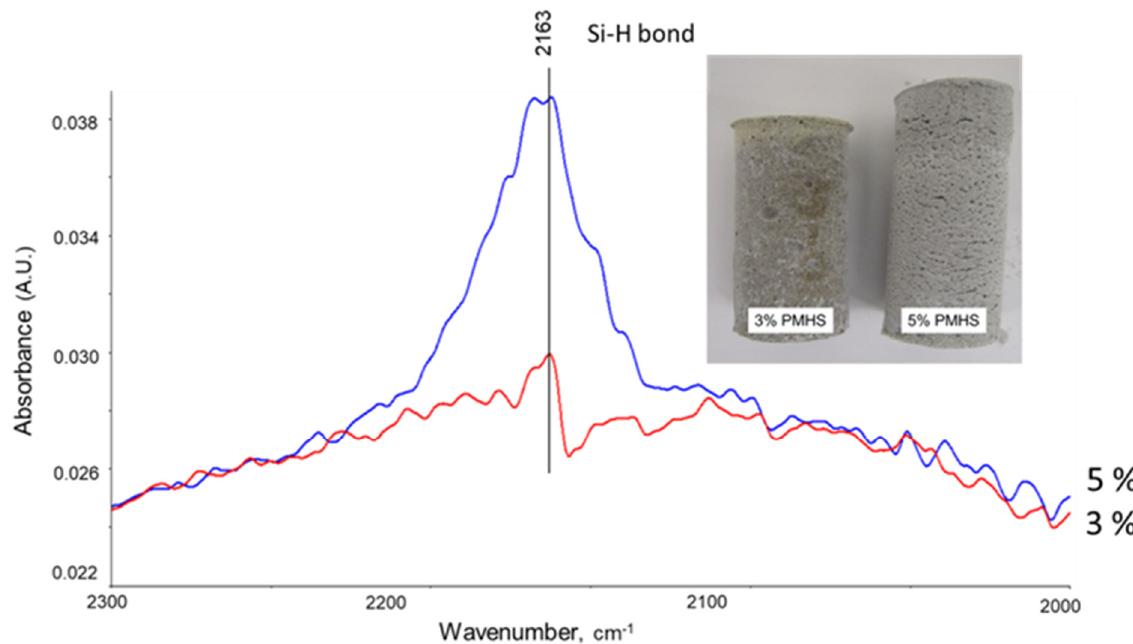
Figure 16. Photograph of cement (CAC/FCS/SMS) volumetric expansion with the 5%-PMHS-treated FCS and comparison of absorbance peak height at 2163 cm − 1 attributed to unreacted Si-H for 3 and 5% PMHS-treated FCS samples.